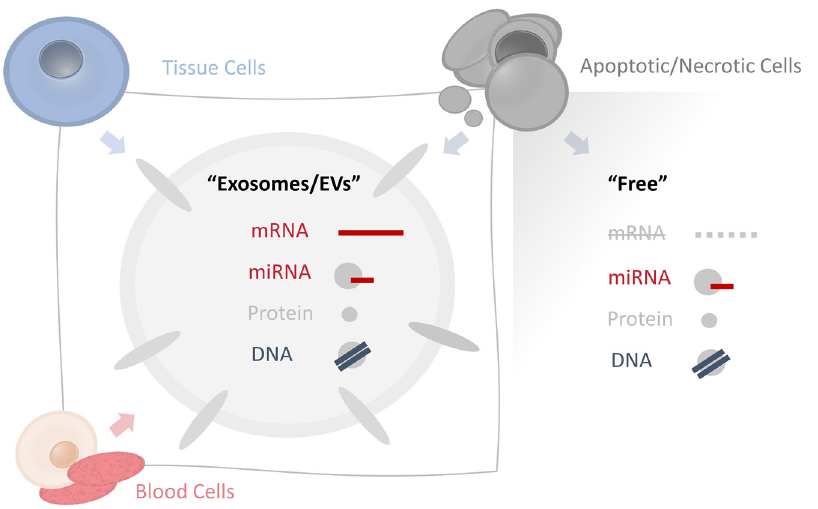
Figure 1: Liquid